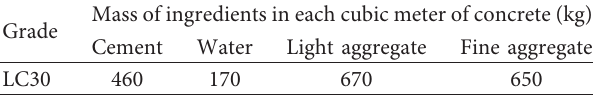
Table 1: Light aggregate concrete mix ratio.